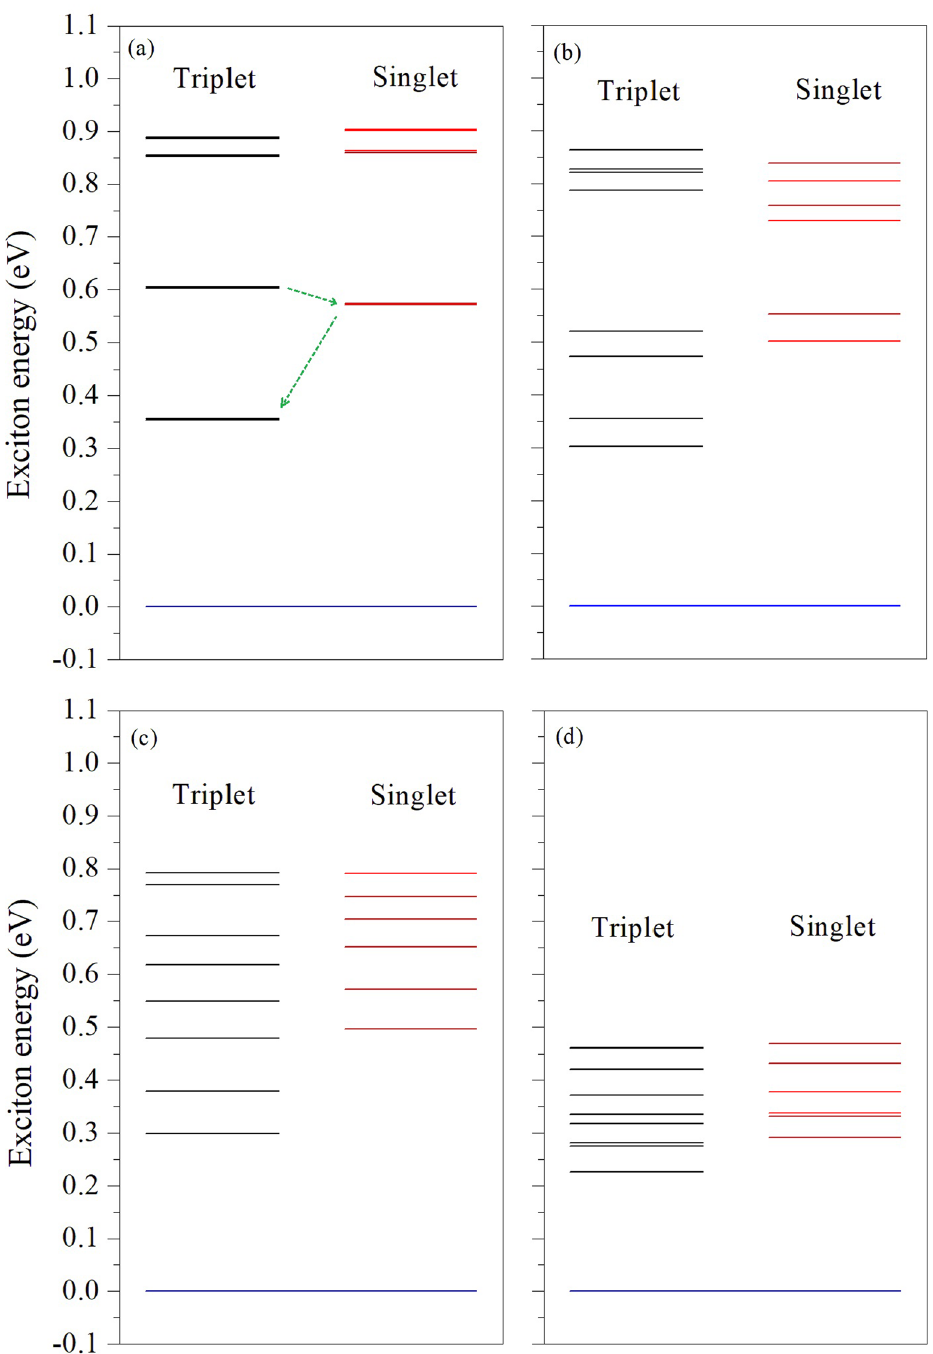
Figure 7. Energy levels of several low energy singlet and triplet excitons for A13MoS 2 nanoribbon at different bending curvature radii R : ( a ) R = ∞ , ( b ) R = 13 Å , ( c ) R = 9 Å and ( d ) R = 6 Å . The dashed green arrows in ( a ) indicate the possible intersystem crossing between singlet and triplet